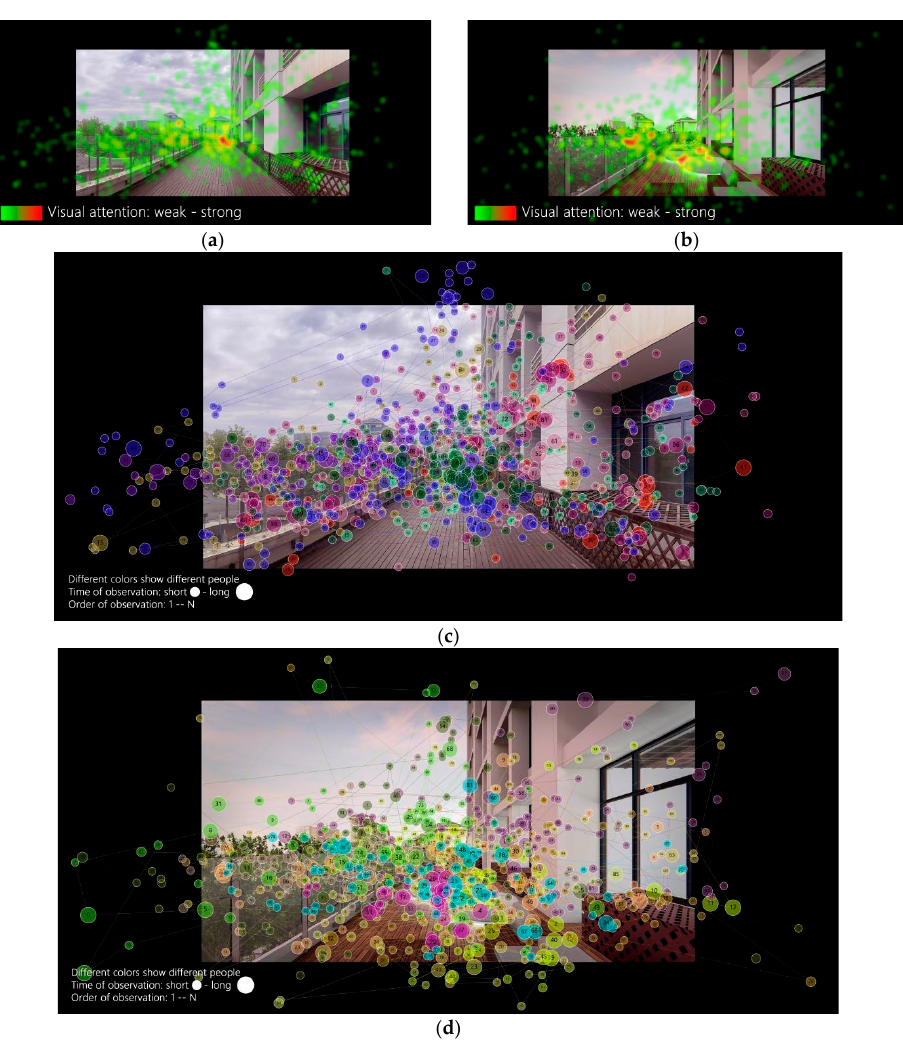
Figure 10. Distribution of eye-tracking data of the third-floor terrace. ( a ) The heat map before optimization. ( b ) The heat map after optimization. ( c ) The gaze plots before optimization. ( d ) The gaze plots after optimization.